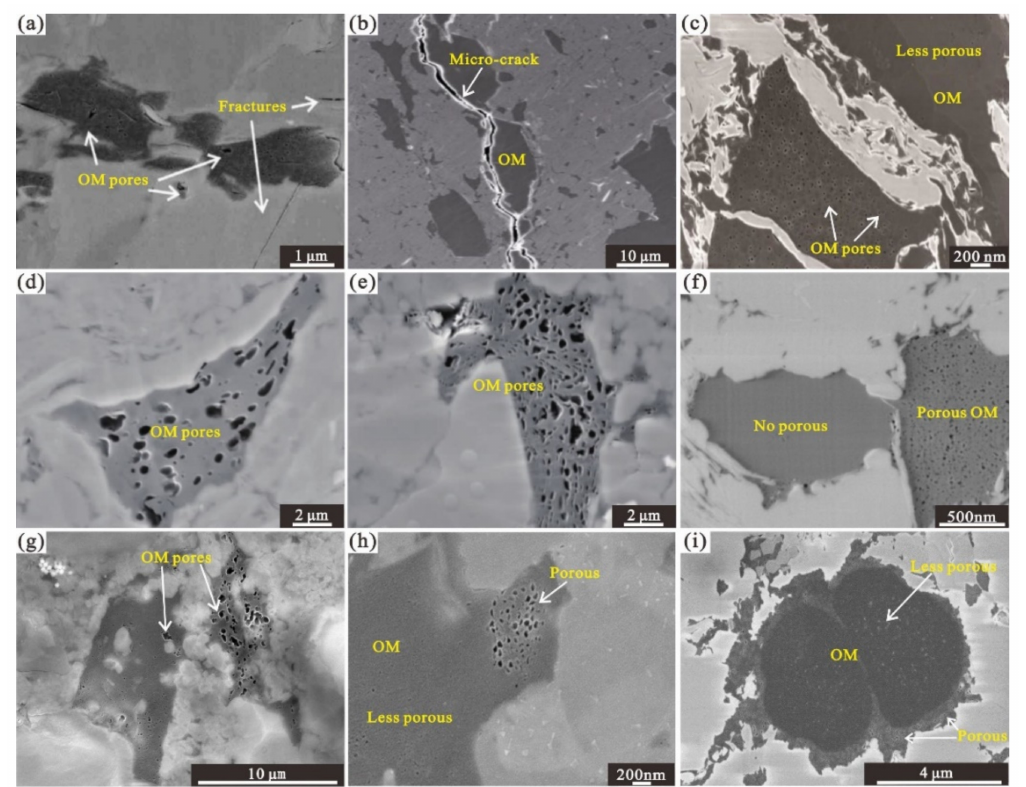
Figure 1. SEM photographs showing pore characteristics of fine-grained and dispersed OM particles in different types of highly-mature to over-mature shale: ( a ) Organic pores are developed, but pore size is small and the distribution of pores is uneven in Permian coal-bearing shale with type III kerogen in the southern North China Basin [14]. ( b ) Pores are not developed in the OM particles, while micro-cracks can be observed in Permian coal-bearing shale with type III kerogen in the Ordos Basin [75]. ( c ) The development degree of pores varies greatly in OM macerals with different sizes of Permian marine–continental transitional shale in the Northern Guizhou area. OM particles in the lower left corner are relatively porous, but pore size is small. Pores are poorly developed in the OM particles in the upper right corner [76]. ( d , e ) The porous OM particles can usually be observed in Wufeng–Longmaxi Formation shale from the Sichuan Basin, and pore size is relatively large [77]. ( f ) Pore characteristics visibly displayed in different OM particles of Woodford shale [27]. ( g ) The development degree and characteristics of pores are obviously different in different organic particles of Wufeng–Longmaxi Formation shale in the Sichuan Basin [20]. ( h ) Strong heterogeneity of pores occurred in the same OM particle of Lower Cambrian shale in the Chongqing area [62]. ( i ) Pores are unevenly developed in a spherical OM particle of the Wufeng Formation shale from Well PS1 in the Sichuan Basin, which displays porous characteristics in the rim but fewer pore characteristics in the core (unpublished